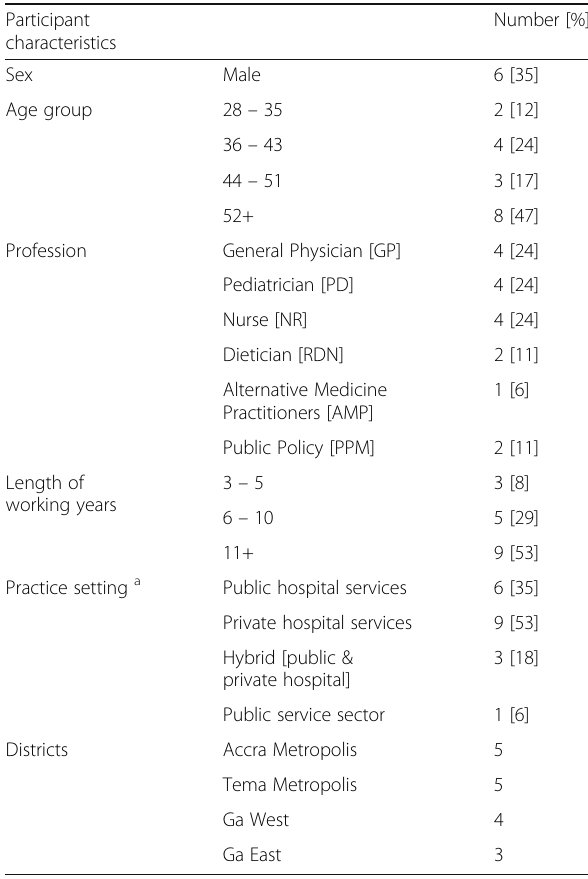
Table 1 Characteristics of healthcare participants [ n = 17] Participant